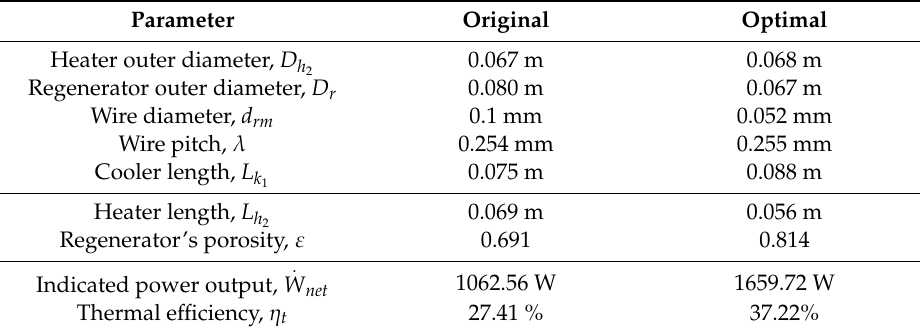
Figure 10. P-V diagrams of the original and optimal designs. ( a )Expansion chamber; ( b ) Compression chamber. Table 6. Optimal designed parameters and performance improvement.